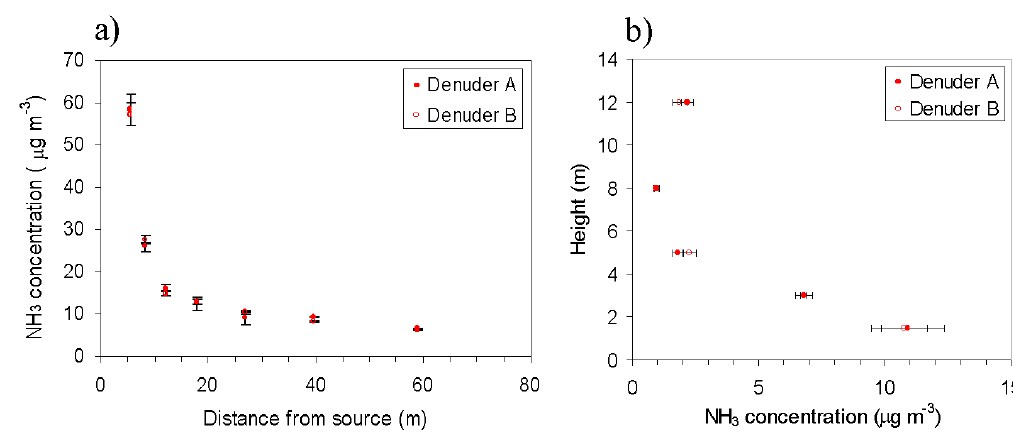
FIGURE 7. Ammonia concentration profiles for (a) a horizontal transect at 1.5 m above ground and (b) a vertical transect at 45.2 m from the source. Error bars are ± 1 standard error of the concentrations measured over the period the AMANDA was at each